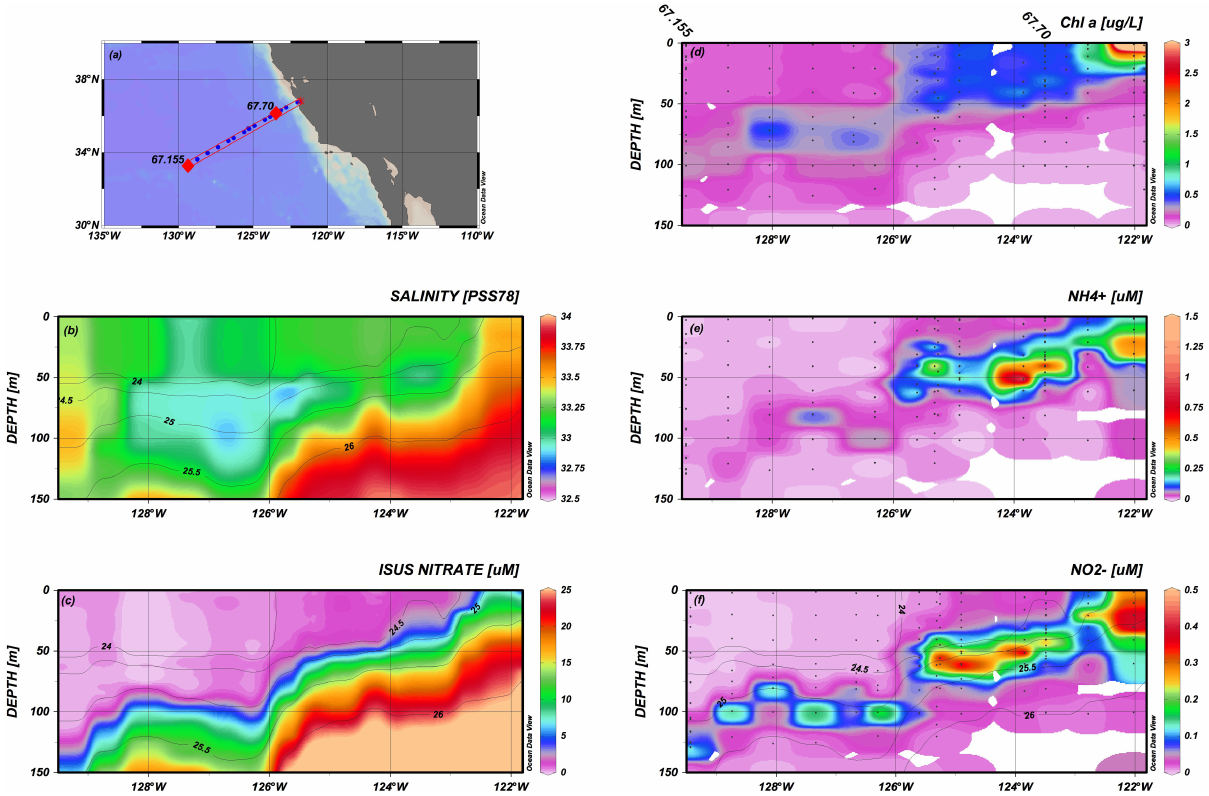
Fig. 1. Longitudinal sections along (a) CalCOFI Line 67 in the eastern North Pacific Ocean, September 2009, of (b) salinity, (c) nitrate ([NO − ]) from an in situ ultraviolet spectrophotometer (ISUS), (d) Chl a ( µ gL − 1 ) extracted from GF/F filters, (e) ammonium (NH + 3 ) . Data are shown from the westbound transect. Isopycnal surfaces (potential density anomaly, sigma theta) are overlaid as (f) nitrite (NO − 2 black contour lines in panels (b) , (c) , and (f) . Sections made in Ocean Data View version 4.5.1 (http://odv.awi.de) using the VG gridding